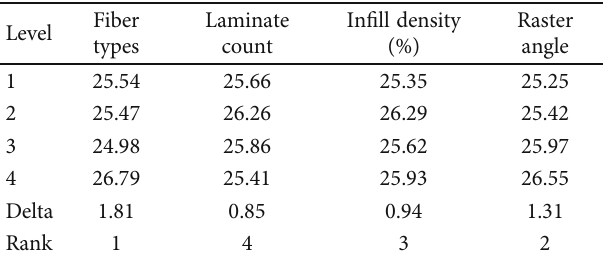
Figure 10: Flexural strength: 3D plot of raster angle and fi ber types. Table 4: Response table for signal to noise ratios ( fl exural